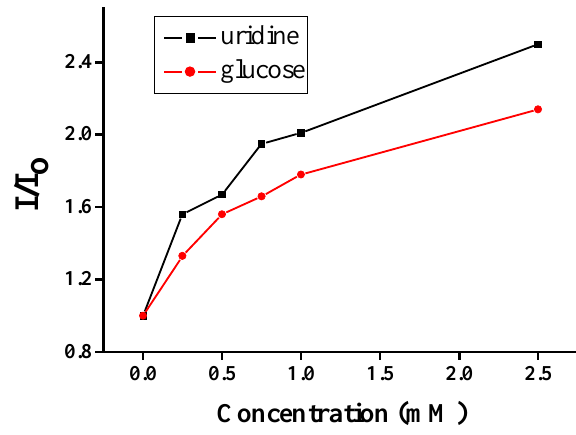
at 420 nm vs. the concentrations of uridine o O (1:1, v/v) with λ = 370 2 ex